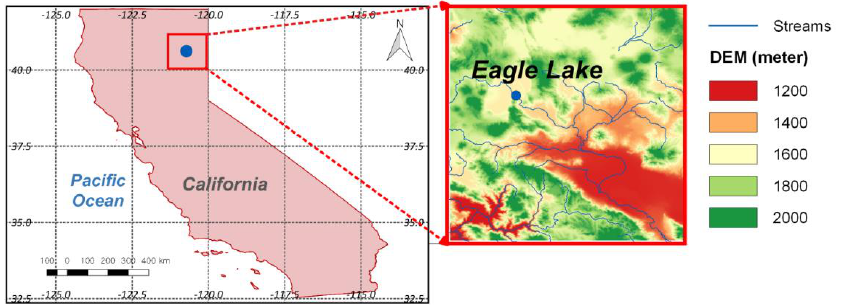
Figure 1. Study area and digital elevation model (DEM). The blue point indicates a SCAN observatory for monitoring various elements.